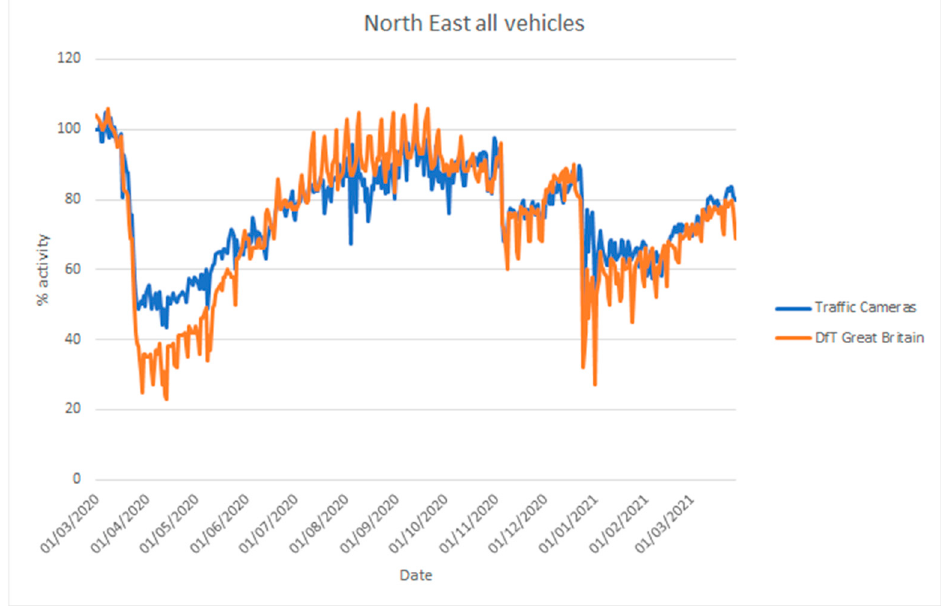
Figure 19. Comparison of time series describing traffic levels between 1 March 2020 and 28 March 2021 based on road traffic statistics for Great Britain produced by the Department for Transport (DfT) using automatic traffic counters and data produced by traffic cameras from North East England (NE travel data). Traffic levels are given as a percentage activity index baselined to counts, from the respective source, on 11 March 2020.